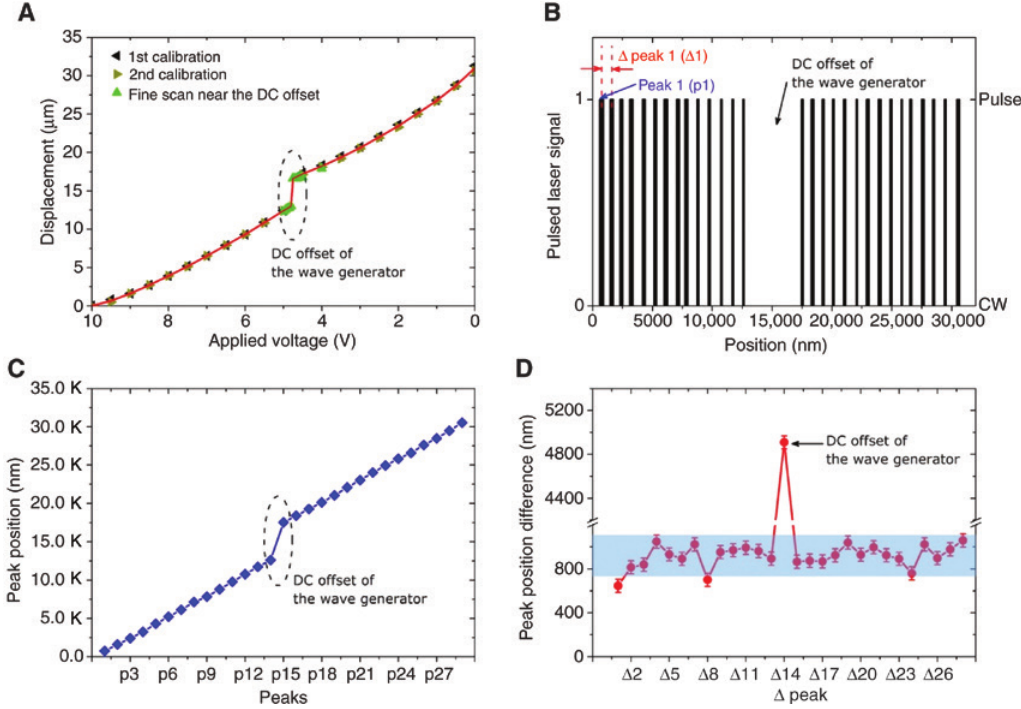
Figure 3: Laser operation mode